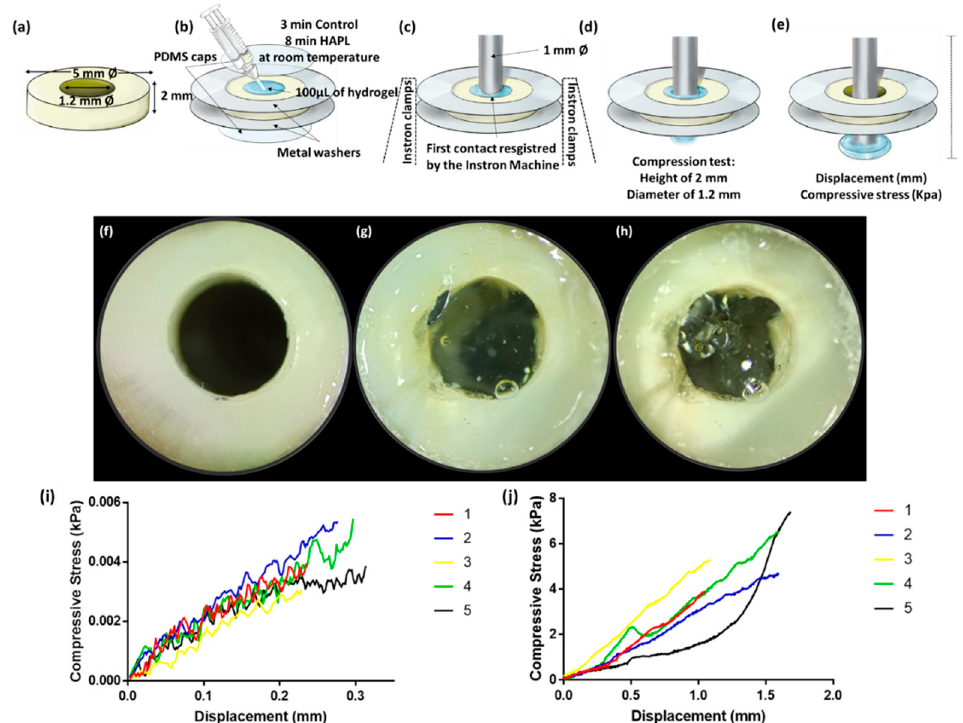
Figure 3. Indentation test. ( a ) Dentin disc obtained from a sound tooth. ( b ) Sample preparation. ( c ) Dentin disc mounted on the Instron machine before starting the test. ( d ) The metal stem is introduced at a continuous rate into the simulated canal filled with the hydrogel. ( e ) The breaking- point corresponding to hydrogel’s loss of integrity or detachment from the dentin walls. ( f ) Pre- conditioned dentin disk before injection of the hydrogel. ( g ) Simulated root canal filled with HAPL, ready to be used on the indentation test. ( h ) Same sample after the indentation test. ( i ) Indentation test graphic of control hydrogel or ( j ) HAPL. Each line represents the compressive stress (kPa) curve or one individual sample.